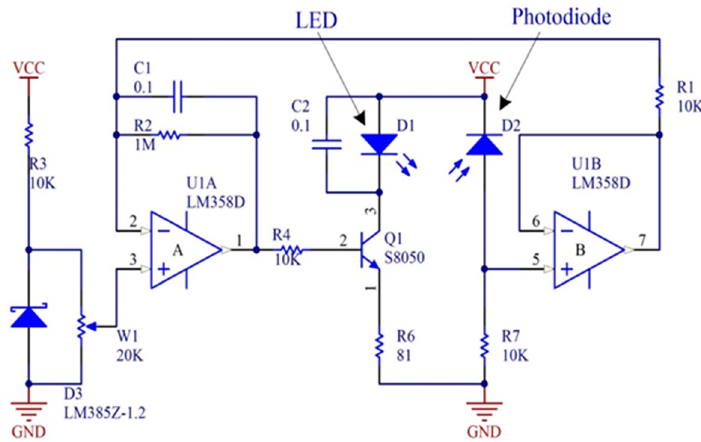
Figure 2. Constant light intensity circuit diagram.